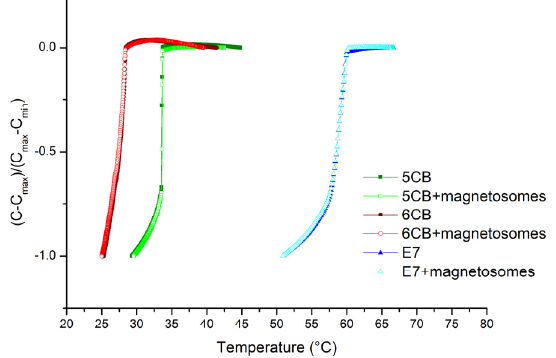
Figure 3. Temperature dependence of reduced capacitance of the pure LCs (5CB, 6CB, E7) as well as doped with magnetosome particles of concentration 0.2 wt%.